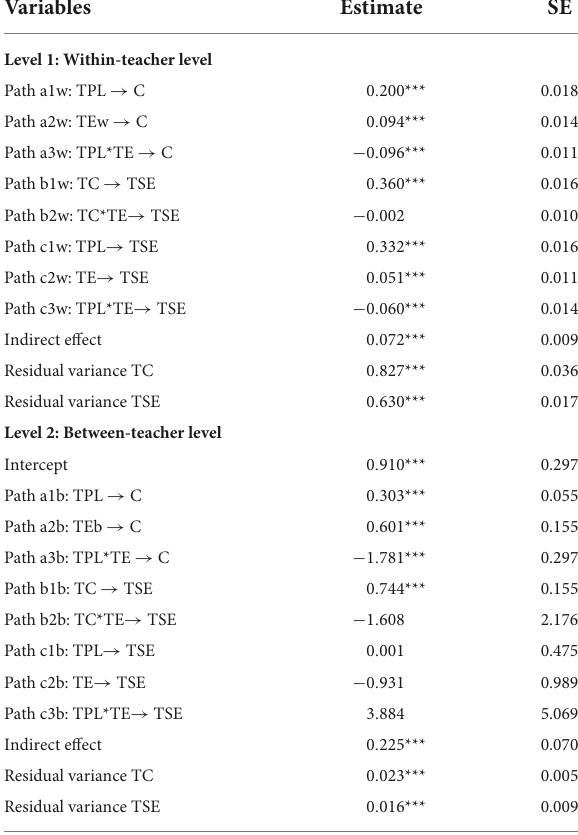
TABLE 3 Coefficients for the multilevel moderated mediation model predicting teacher self-efficacy.